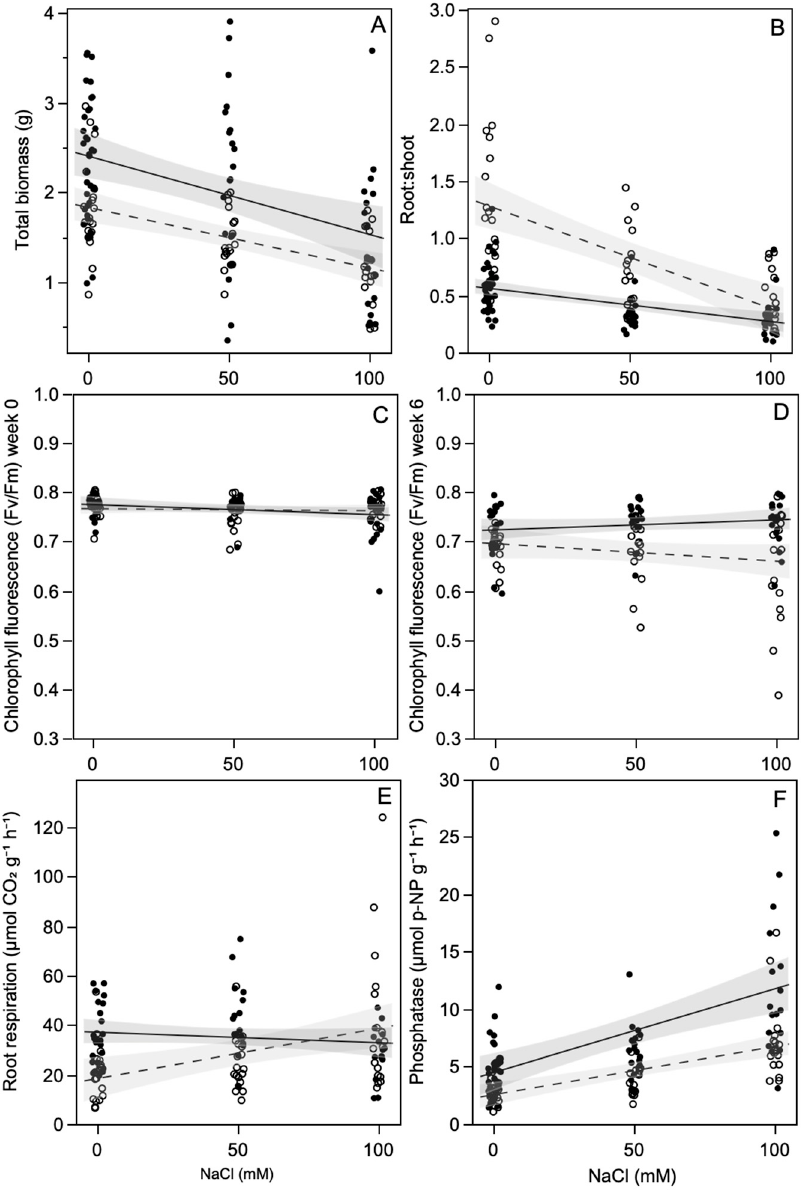
Figure 1. Effect of salt exposure on: ( A ) total plant mass, ( B ) root:shoot ratio, leaf chlorophyll fluorescence prior to ( C ) and six weeks after ( D ) salt exposure, ( E ) root respiration excluding nodules and, ( F ) root extracellular acid phosphatase activity, of Frankia -inoculated (closed symbols, solid line) and non-inoculated plants (open symbols, dashed line) averaged across ECMF inoculation treatments. Lines are least squares fits with 95% confidence